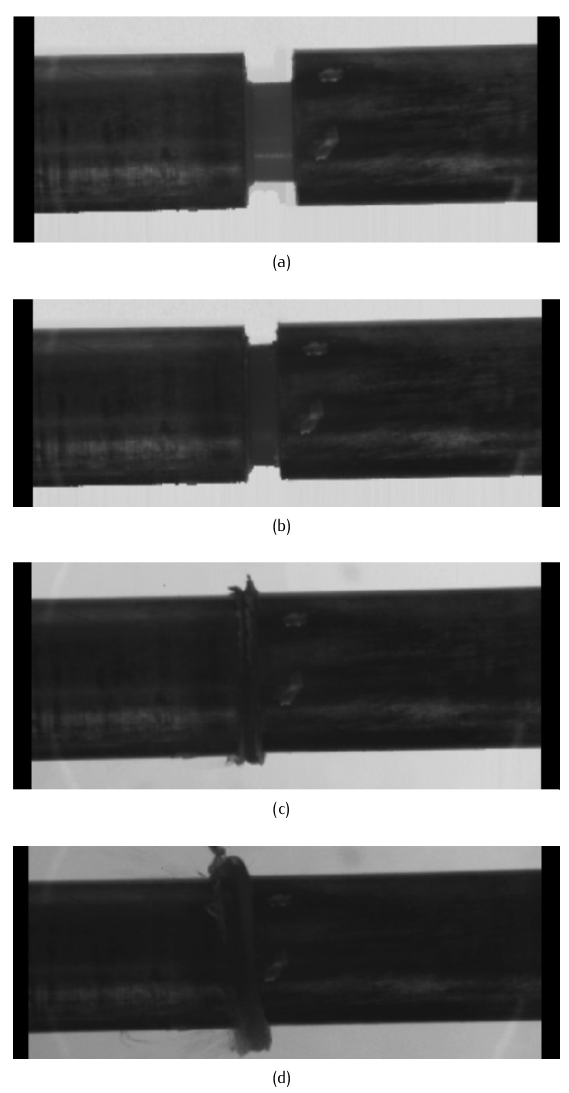
Figure 5. High speed images of SHPB test a) Before impact b) at first impact c) at second impact d) at third impact.